Question: Write the caption for this figure.
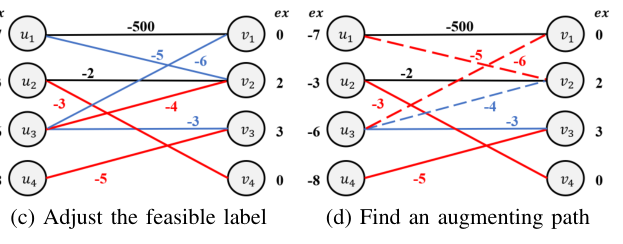
Answer: An illustrate of the KM-M algorithm.